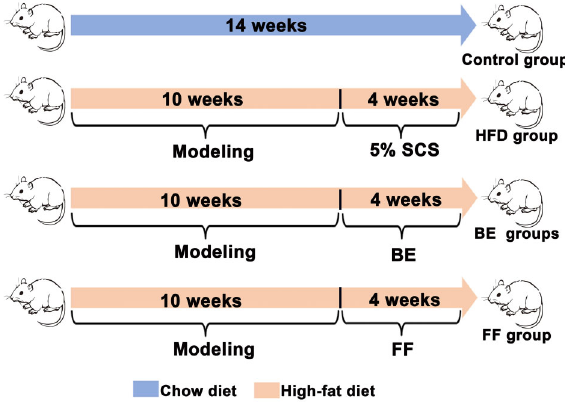
Figure 1. Experimental design. SCS: sodium carboxymethyl cellulose; BE: berberine and evodiamine; FF: feno fi